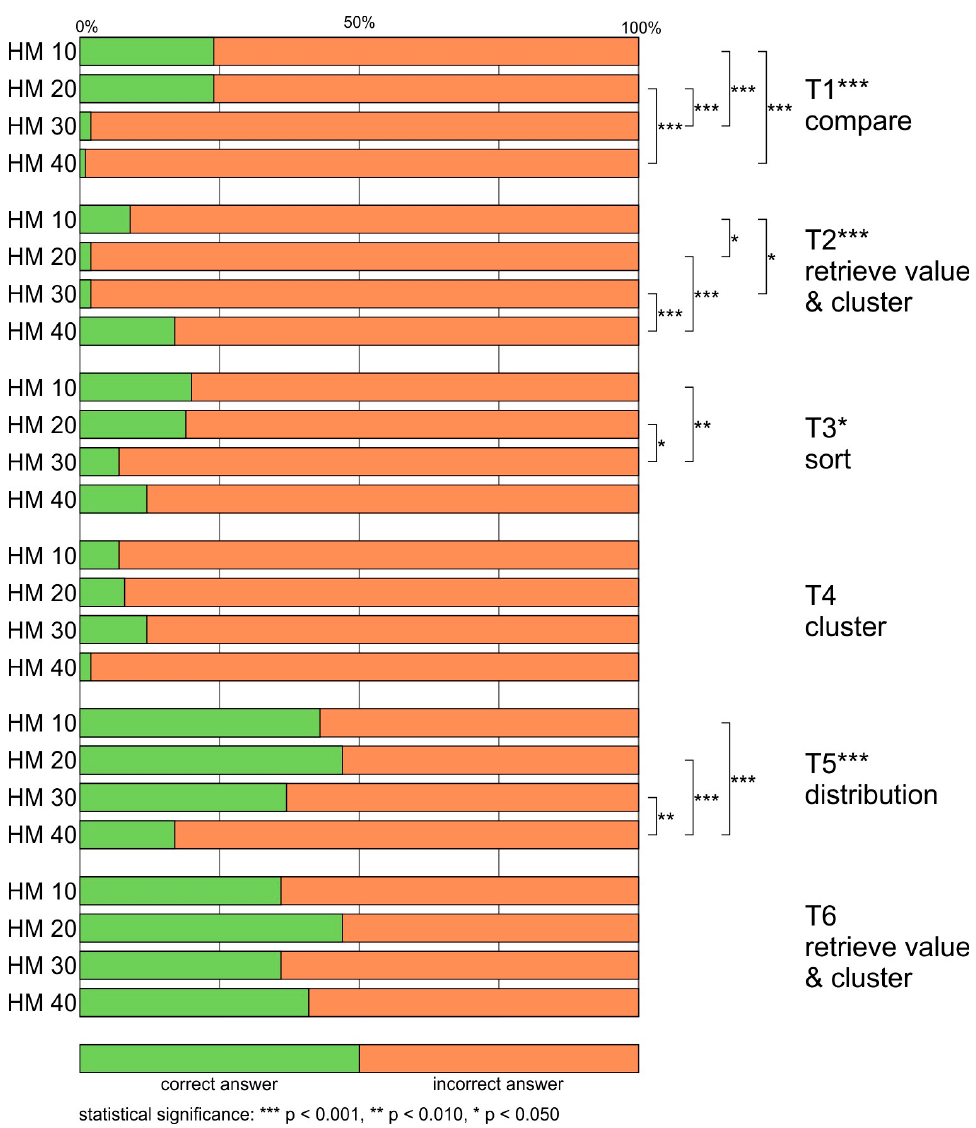
Table 3. Inferential statistics for answer accuracy between participants using the four tested heat maps.